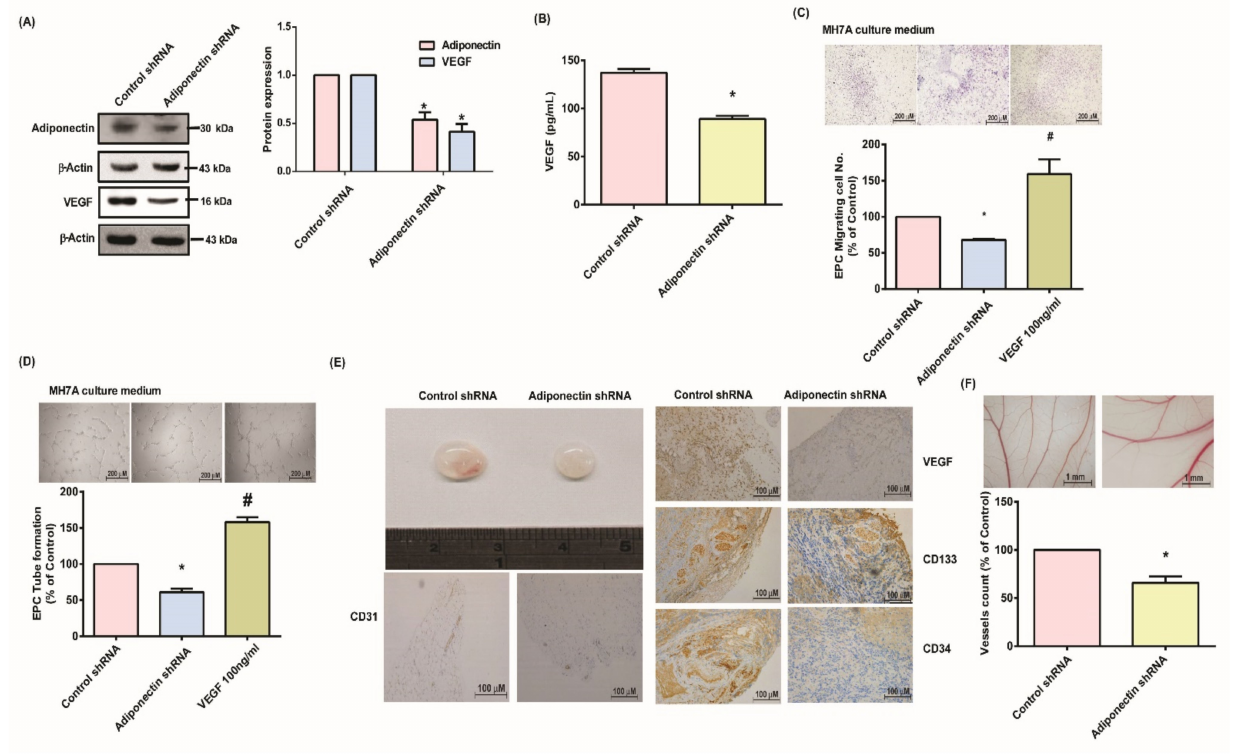
Figure 6. Blocking adiponectin attenuates RA angiogenesis in vivo. ( A , B ) MH7A cells were infected with adiponectin shRNA for 24 h. Adiponectin and VEGF expression was examined by Western blot ( n = 4) and ELISA ( n = 4). ( C , D ) Collected CM was applied to EPCs and EPC angiogenesis was quantified. ( E ) Matrigel plugs containing the harvested CM were subcutaneously injected into the flanks of nude mice. After 7 days, the plugs were photographed and hemoglobin levels were quantified. Plug specimens were immunostained with CD31 ( n = 6), CD34 ( n = 6), and CD133 ( n = 6) antibodies. ( F ) After subjecting MH7A cells to the treatment conditions as indicated, the harvested CM was applied to 5-day-old fertilized chick embryos for 3 days. CAMs were examined by microscopy and photographed ( n = 6), and vessels were counted manually. * p < 0.05 versus the control group; # p < 0.05 versus the adiponectin shRNA-transfected